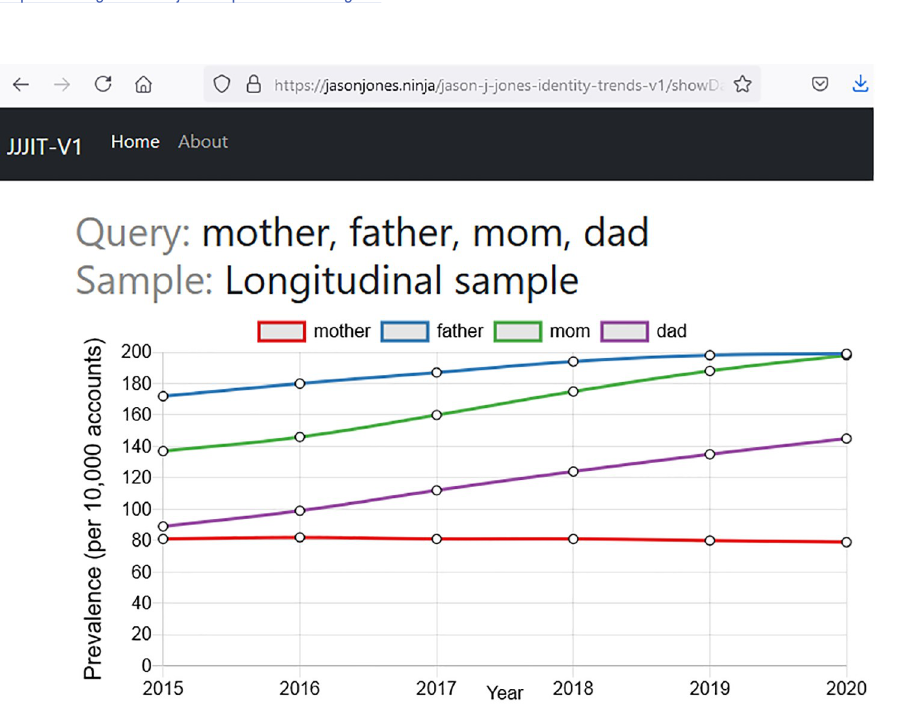
Fig 6. Example results from the web tool.